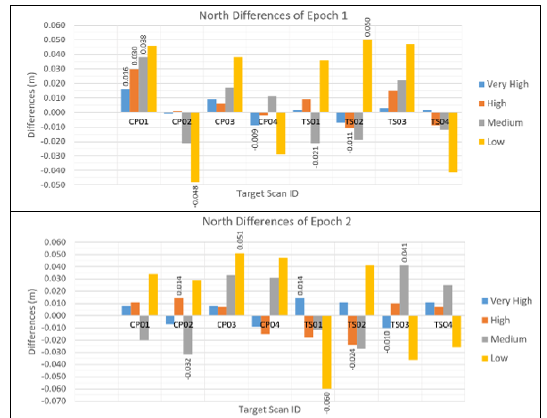
Figure 50. Northing coordinates differences between point cloud data by picking point manually and Total Station data using intersection method (epoch 1 and 2)